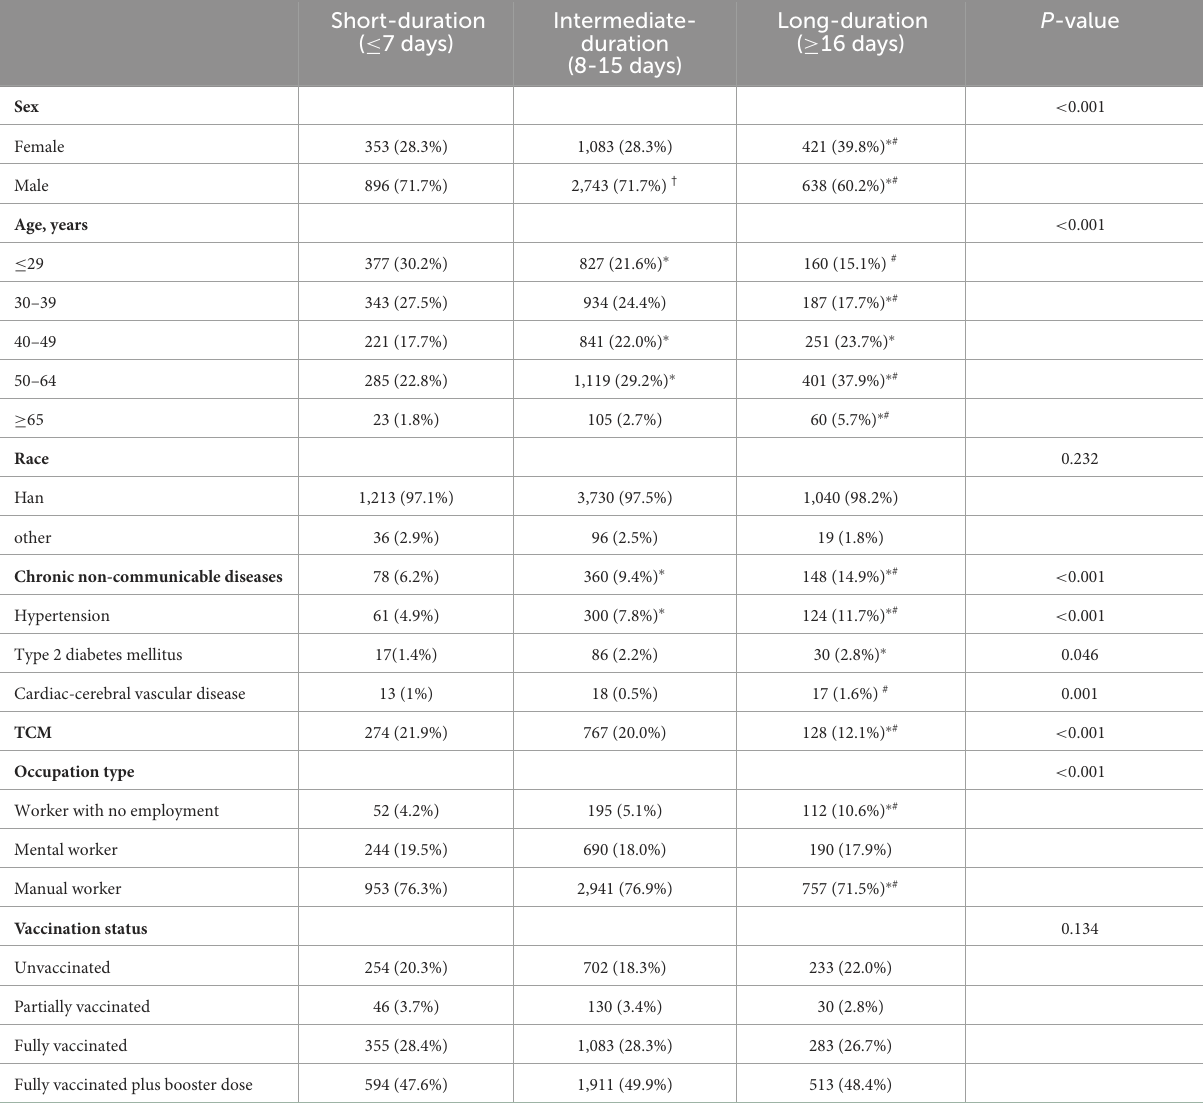
TABLE 1 The basic characteristics of enrolled